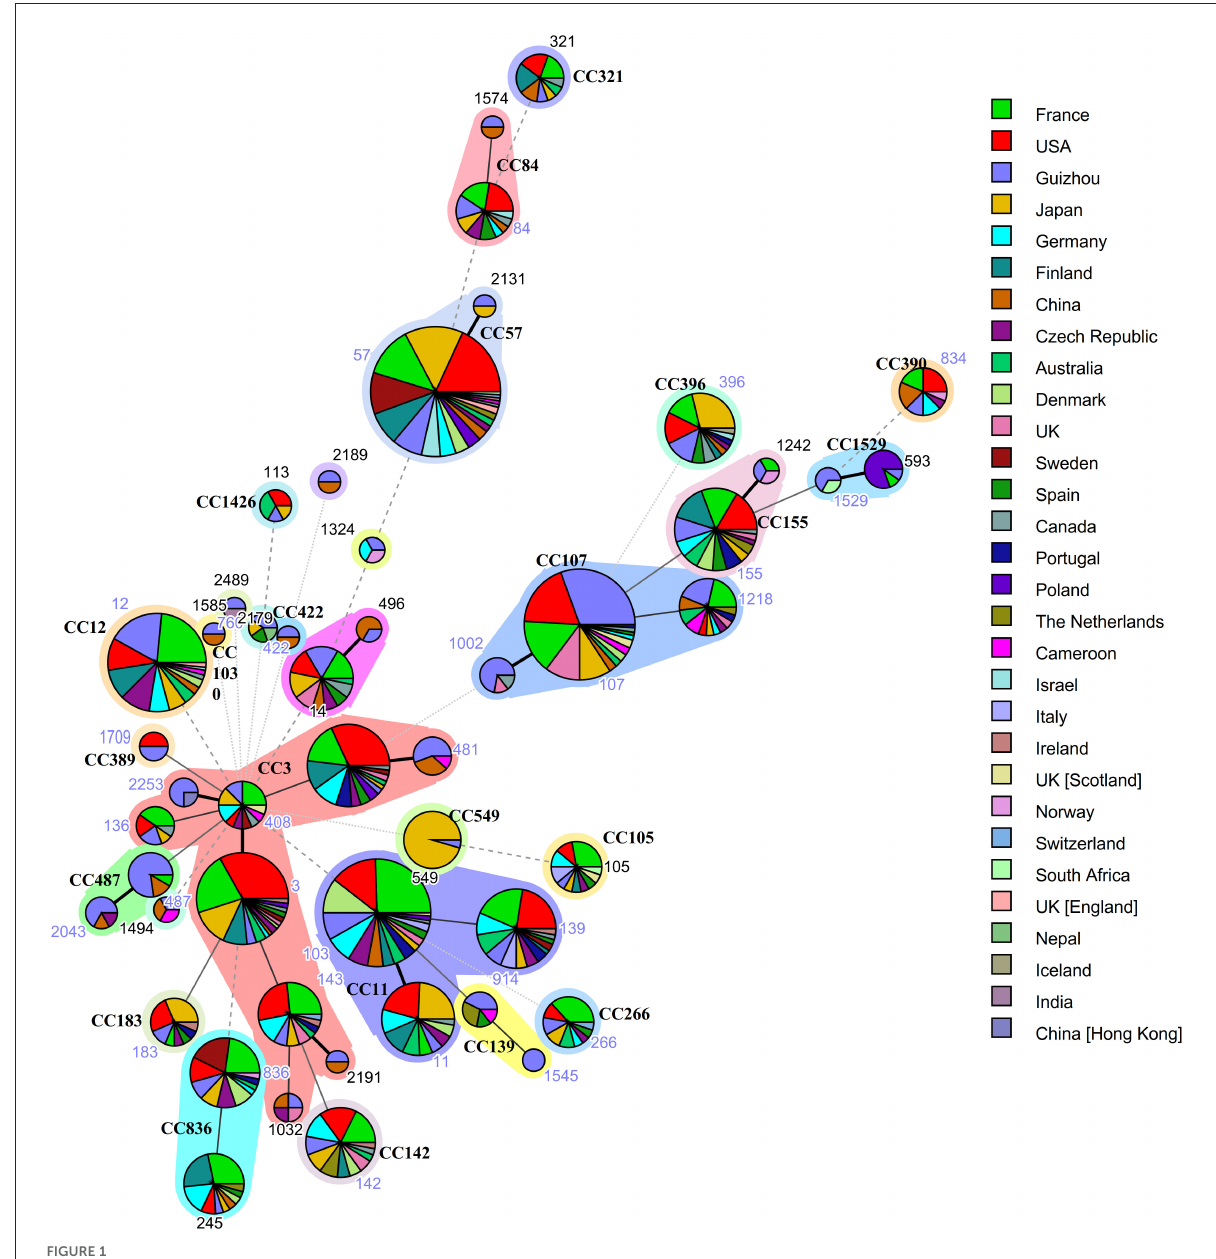
FIGURE1 Genetic relationships based on minimum spanning tree of the 161 MLST profiles of H. influenzae isolates from Guizhou province and isolates of worldwide distribution. Each circle corresponds to a MLST profiles. The shadow zones in different color correspond to different clonal complexes. The size of the circle is proportional to the number of the isolates, and the color within the cycles represents the locality origin. Numbers in nodes denote sequence types and clonal complexes (CC), of which 49 different ST and 23 CC were identified.The solid and dotted lines indicate the single-locus variant and the double-locus variant,